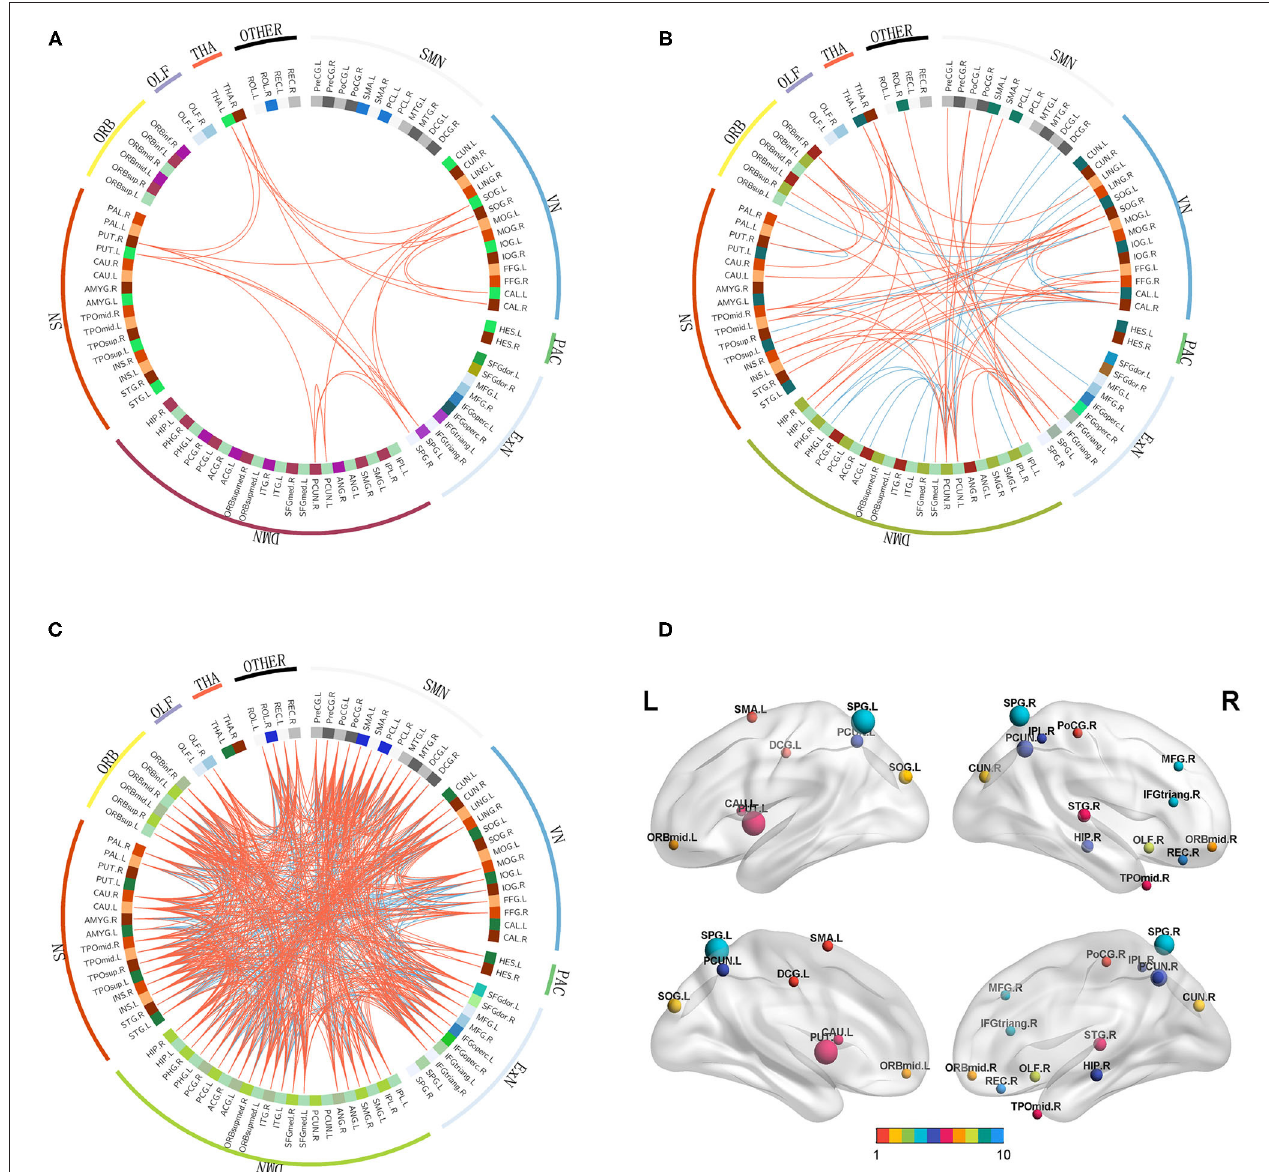
FIGURE 6 | (A–C) : Consensus functional connections. The red lines represent positive connections, and the blue lines represent negative connections. (D) : The distribution of weighted regions in the NSCLP group. The size of the balls indicates the normalized classification weights, and the color of the balls represents the intrinsic connectivity networks. (1:SMN, sensorimotor network; 2:VN, visual network; 3:ExN, frontoparietal network; 4:DMN, default mode network; 5:SN, salience network; 6:ORB, orbitofrontal cortex; 7:PAC, primary auditory cortex, 8:THA, thalamus; 9:OLF, olfactory cortex; 10